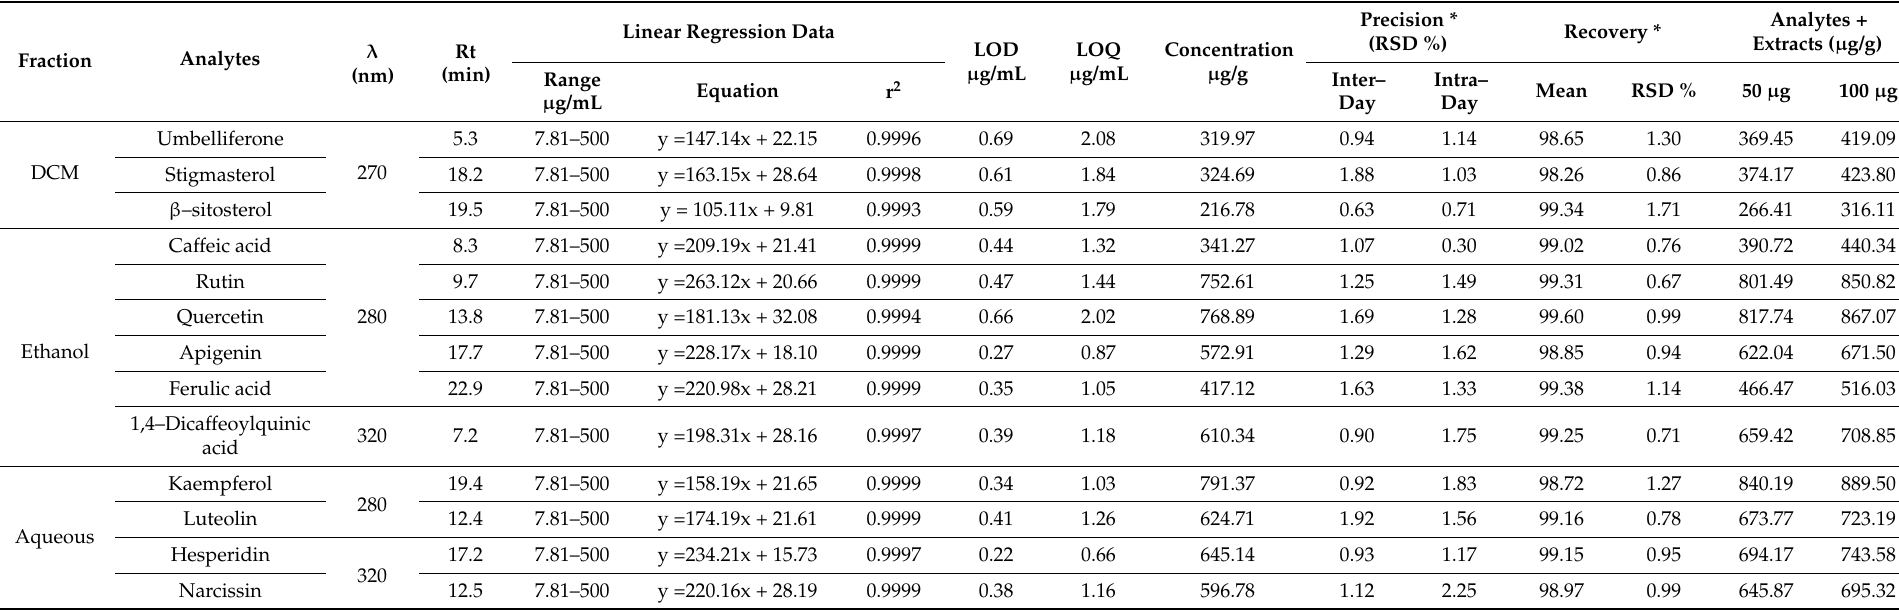
Table 1. HPLC quantification and technique validation of C. melo seed kernel sequential extracts for